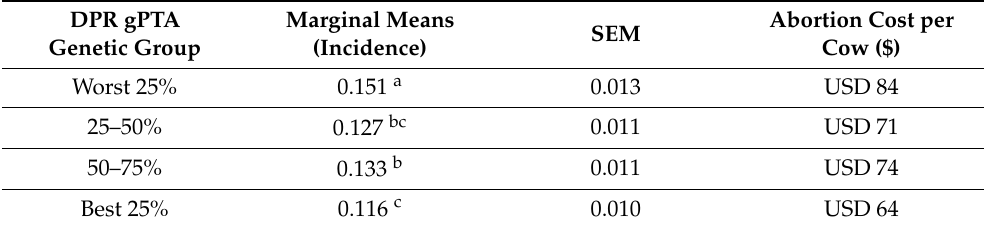
Table 7. Least squares means for DPR gPTA genetic groups (n = 4) abortion incidence ( p = 0.0003), SEM of the genetic groups, and estimated abortion cost per cow. a–c Different letters within the same column represent p < 0.05.